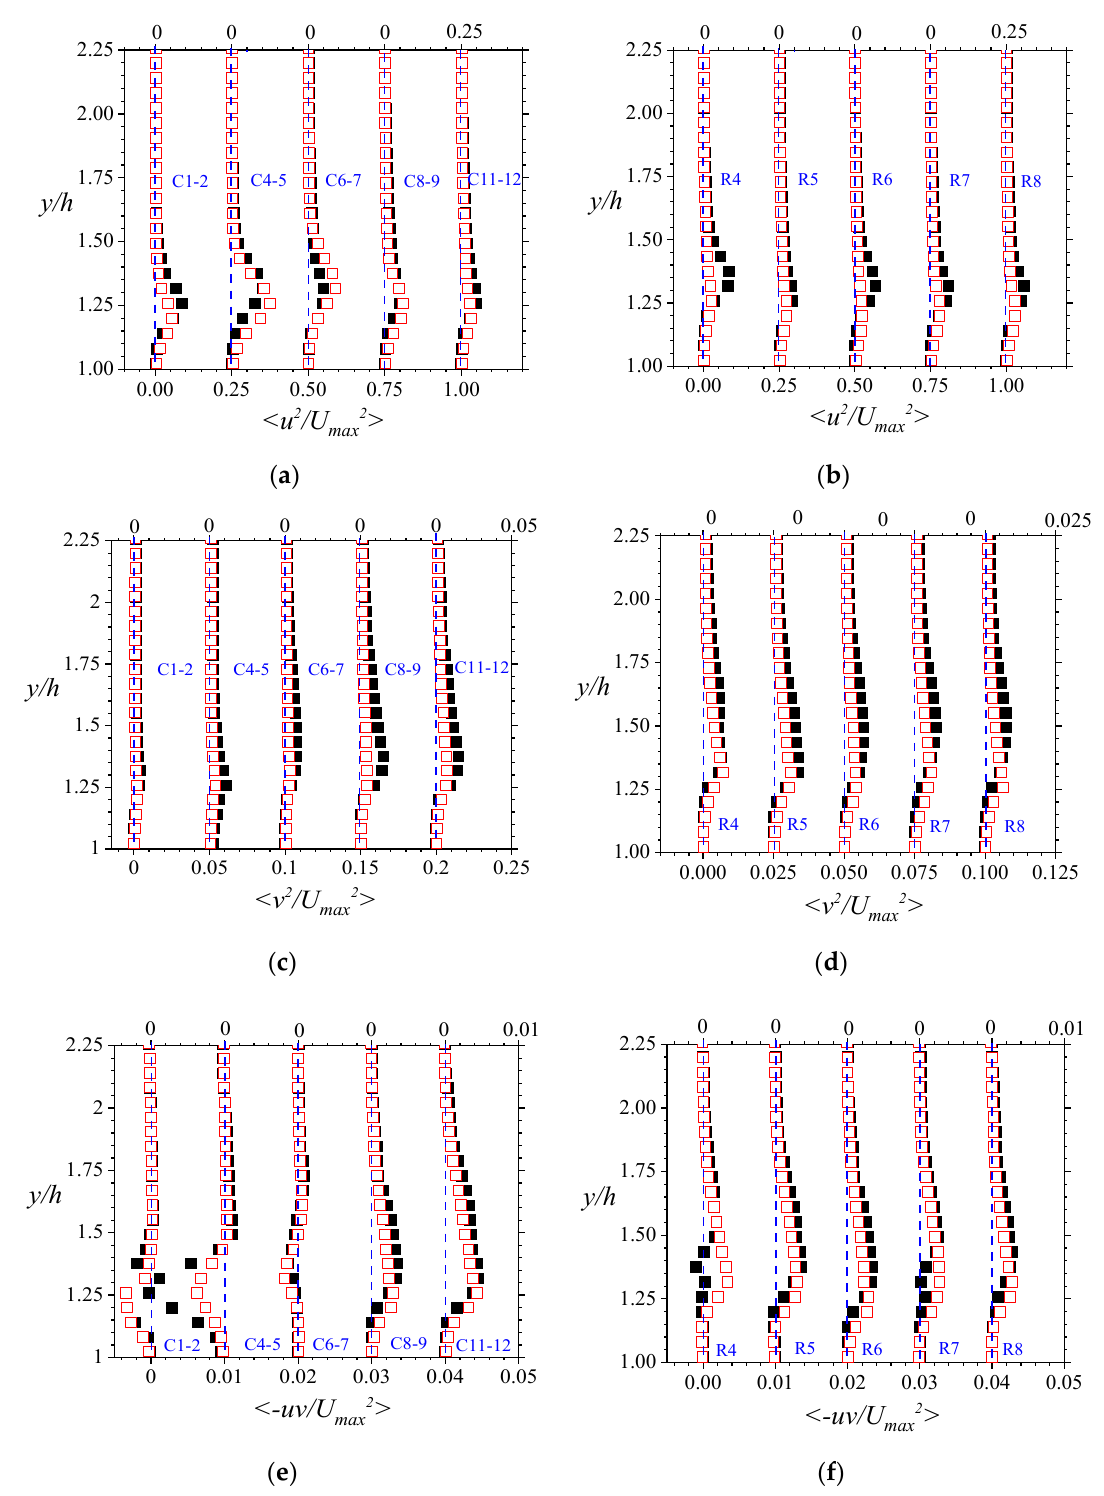
Figure 16. Turbulence quantities < u 2 /U max2 >, < v 2 /U max2 >, and < −uv/U max2 > are respectively line-averaged streamwise Reynolds normal stress, wall-normal Reynolds normal stress, and Reynolds shear stress in the streamwise-wall-normal plane, normalized by the local maximum line-averaged streamwise mean velocity in both open and porous regions. Here, the profiles for the flow in the open region are shown. Staggered plots ( a , c , e ) show the streamwise variations whereas ( b , d , f ) demonstrate the spanwise variations. The denominations C and R respectively stand for columns and rows, and are illustrated in Figure 1. Black-filled boxes are the results for Test A , and red-open boxes are the results for Test B .